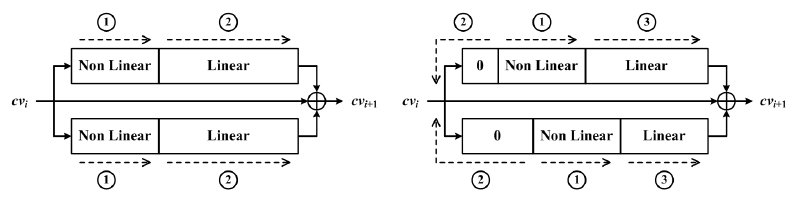
Figure 2: The traditional (left-hand side) and new (right-hand side) approach for collision search on double-branch compression functions